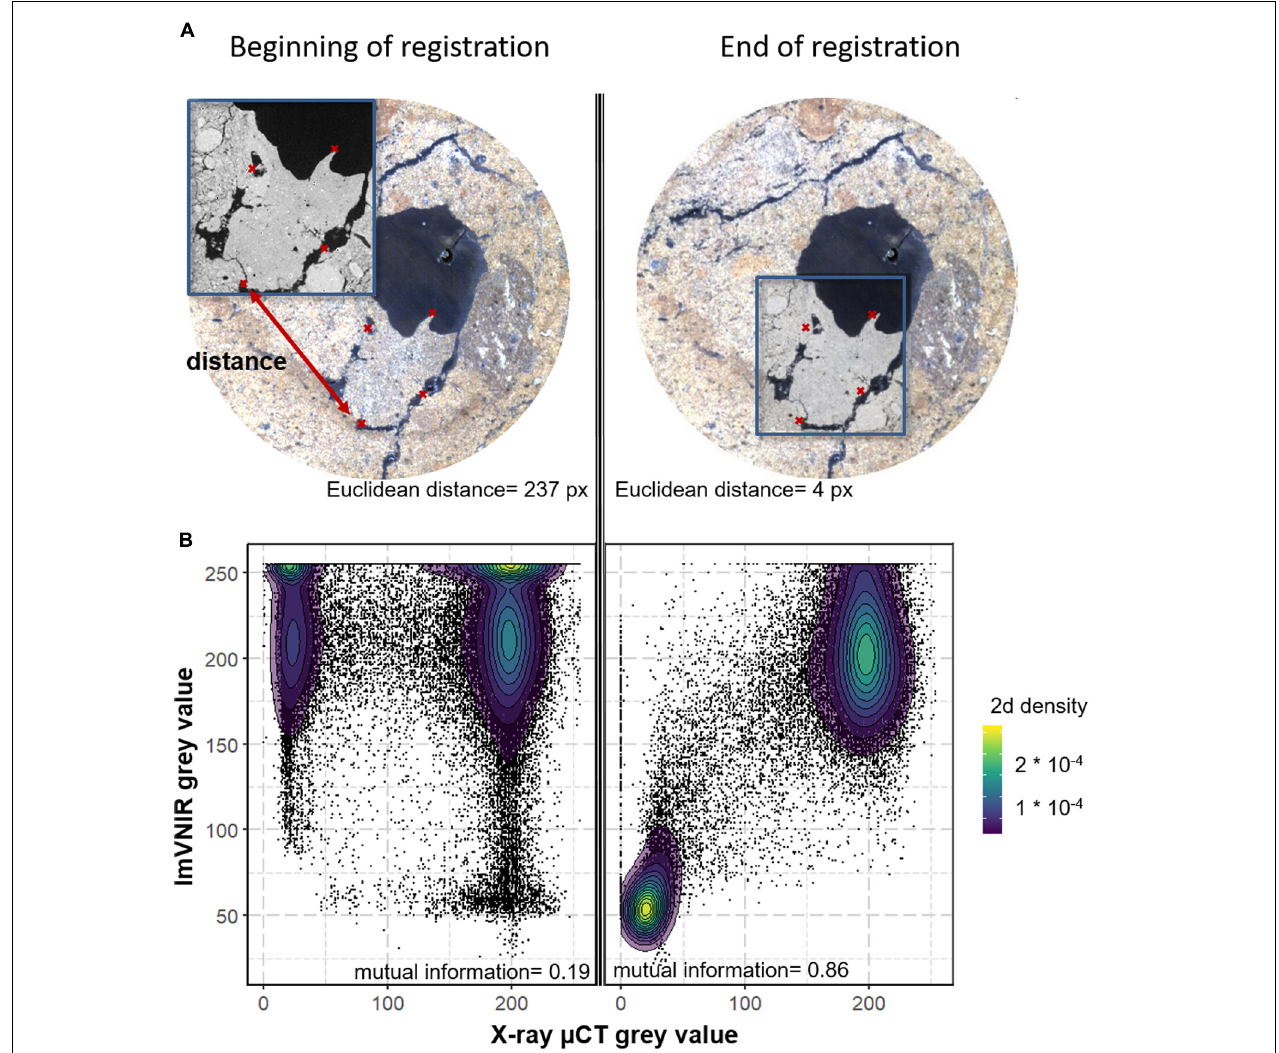
FIGURE 2 | Principle of the image registration. (A) 2D section of the 3D µ CT image (gray) and a 2D imVNIR slice were chosen as a registration example with the software elastix. They were not aligned on each other in the beginning of the registration [ (A) , left]. Through different iterations, the µ CT image was transformed so that both images match at each position [ (A) , right]. For this, the two metrics Euclidean distance and mutual information were used for optimization. The Euclidean distance metric aims to minimize the distance between the manually set points (red crosses). In this example, it is minimized from a mean of 237 to 4 pixel. The second metric represents the extent of mutual information between the registered µ CT image and the imVNIR image, i.e., it measures the “amount of information” given by the µ CT image about the imVNIR and vice versa. The scatter plots of gray values from imVNIR and CT (B) at the beginning of the registration reveals two clusters, which are formed by the µ CT image (pores and matrix) but are not shared by the corresponding imVNIR pixel values. This results in a low mutual information of 0.19. After the final iteration, pore and matrix clusters were formed by both variables, which is also reflected by the isolines showing high kernel densities. Thus at the end of the registration mutual information is high